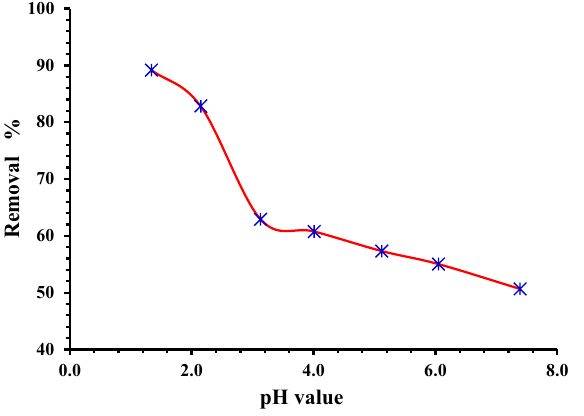
Figure 7. Impact of pH on the absorption of Cr 6+ ions onto MG-OPAC (200 mg/L of Cr 6+ ions, 2 g/L of adsorbent, 25 °C, 200 rpm, 180 min).